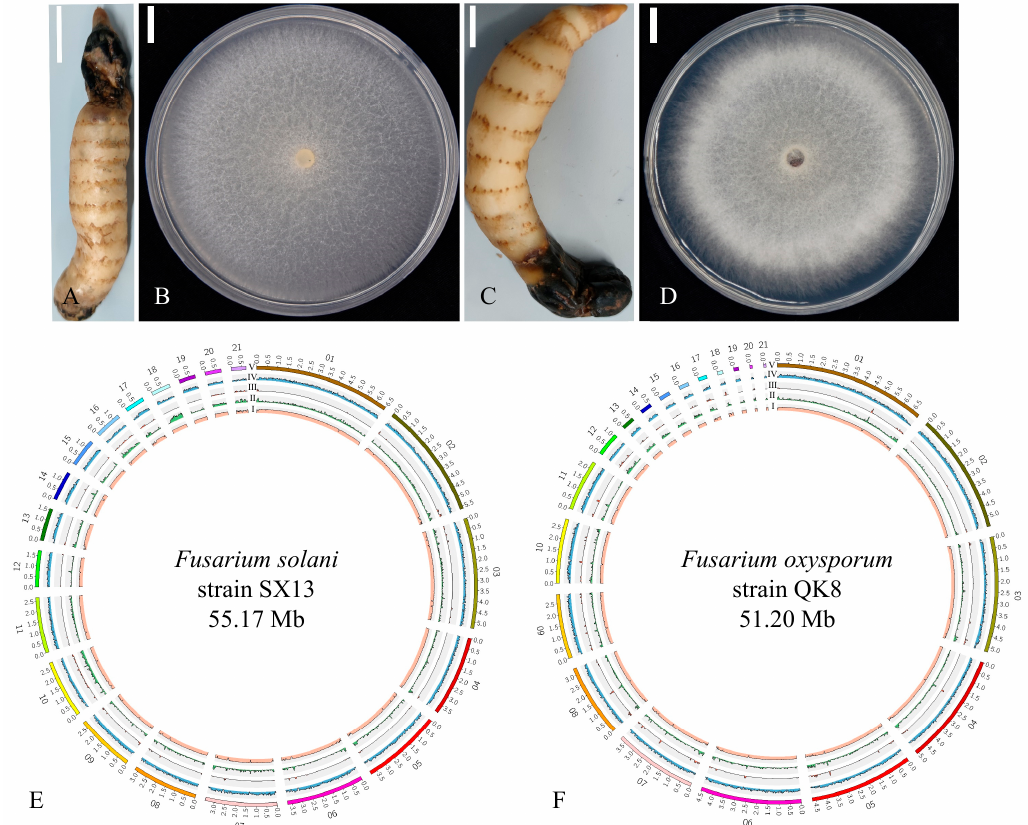
Figure 1. Information on strains SX13 and QK8. ( A , C ): The host of strains SX13 and QK8, respectively. ( B , D ): Colony morphology of strains SX13 and QK8, respectively. ( E , F ): The genome visualization map of strains SX13 and QK8, respectively. I: G+C content; II: repetitive sequence; III: long terminal repeat (LTR); IV: gene density; V: genome fragment size.